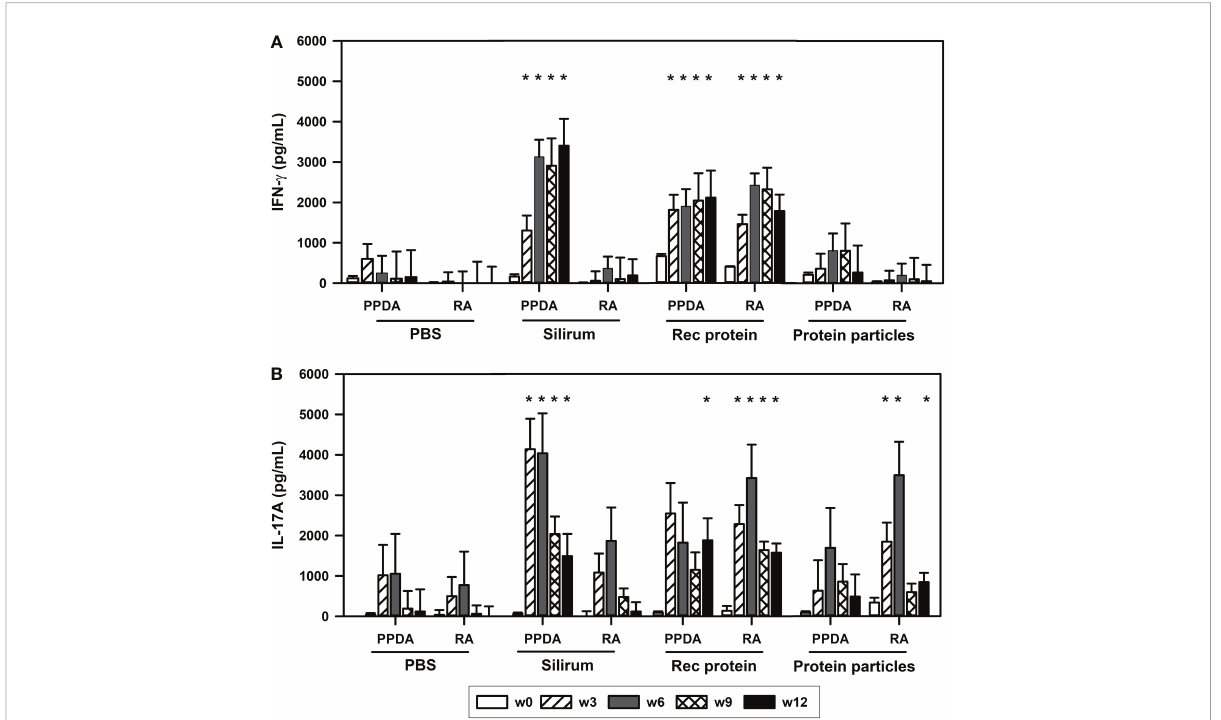
FIGURE 2 Antigen-speci fi c cell-mediated immune responses in the vaccinated animals. Mean (+ SE) (A) , IFN- g and (B) , IL-17A responses in the animals vaccinated with PBS; Silirum ® ; recombinant MAP fusion protein (Rec protein); and protein particles displaying MAP fusion protein (Protein particles). Whole blood from the vaccinated calves at weeks 0, 3, 6, 9 and 12 were stimulated in vitro with PBS, PPDA, or RA. IFN- g and IL-17 levels were measured by ELISA. Results for IFN- g and IL-17A cytokine levels are presented as difference obtained by subtracting values of PBS- from PPDA- or RA-induced IFN- g and IL-17A cytokines. Signi fi cance indicated as *, P < 0.05 compared with the respective treatment in the PBS vaccinated